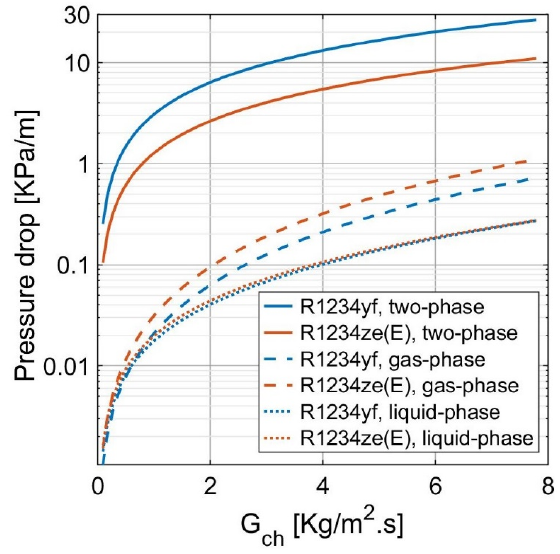
Figure 9. Cold stream pressure drop at various channel mass fluxes.